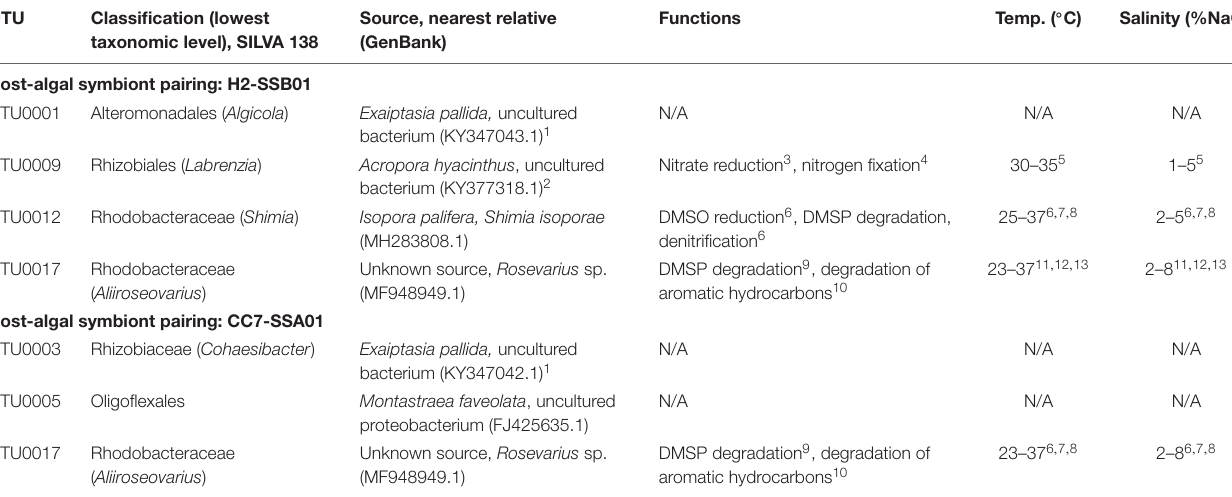
TABLE 3 | Overview of prevalent bacterial taxa associated with Aiptasia anemones H2-SSB01 and CC7-SSA01 under high salinity. OTU Classification (lowest Source, nearest relative Functions Temp. ( ◦ C) Salinity taxonomic level), SILVA 138 (GenBank)